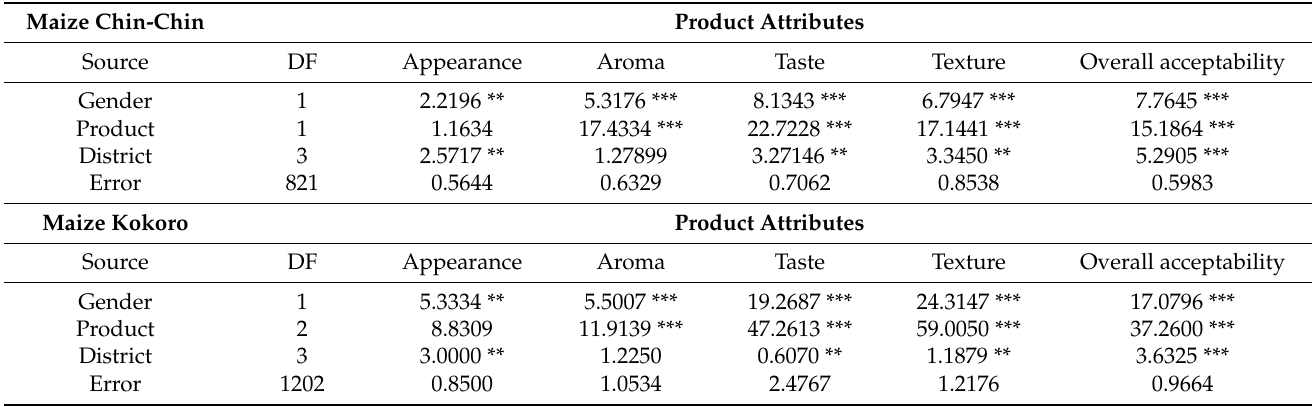
Table 5. ANOVA of consumer preference ratings of maize-based products. Maize